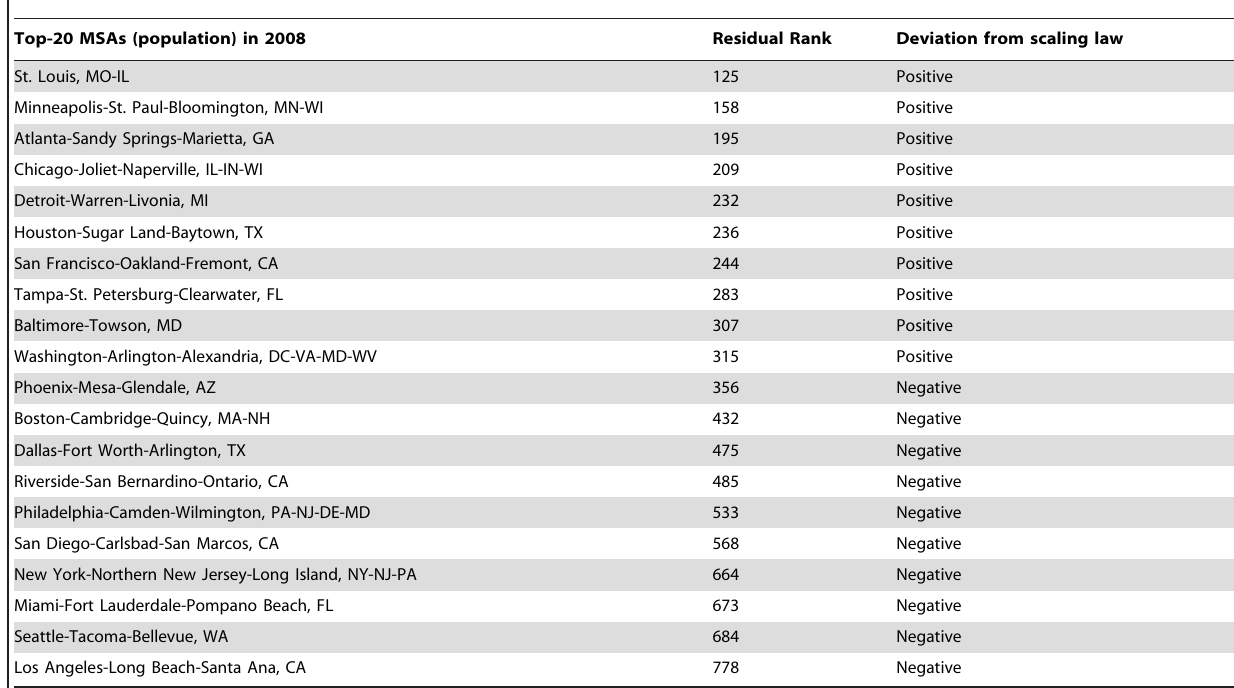
Table 1. The 20 most populous MSAs in 2008 ranked by their deviation from the scaling law.